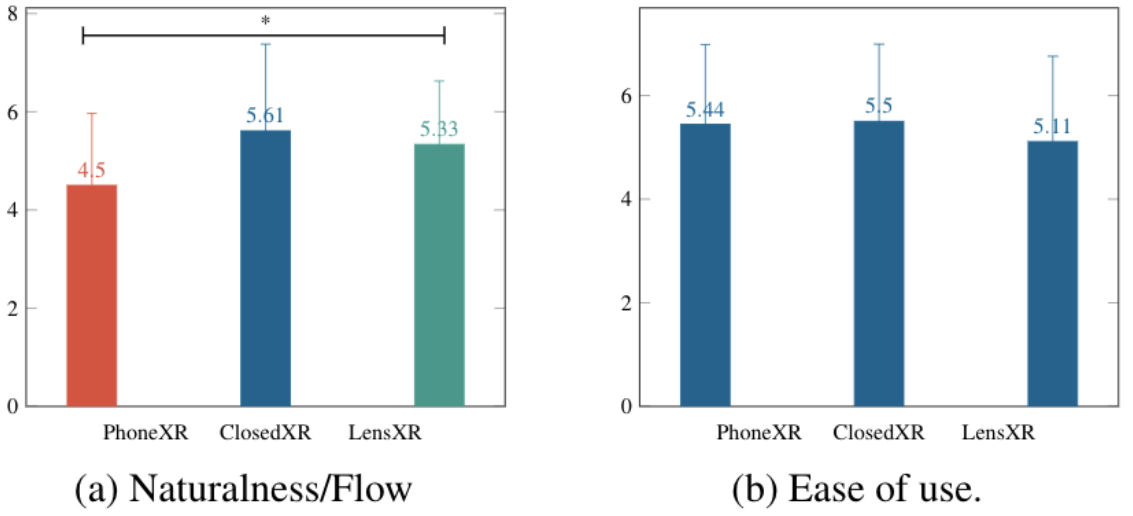
Figure 11. Survey results regarding the multitasking. Statistical differences are indicated by color grouping and the “*” mark. The vertical axes represent the subjective levels in the 7-point Likert scale.